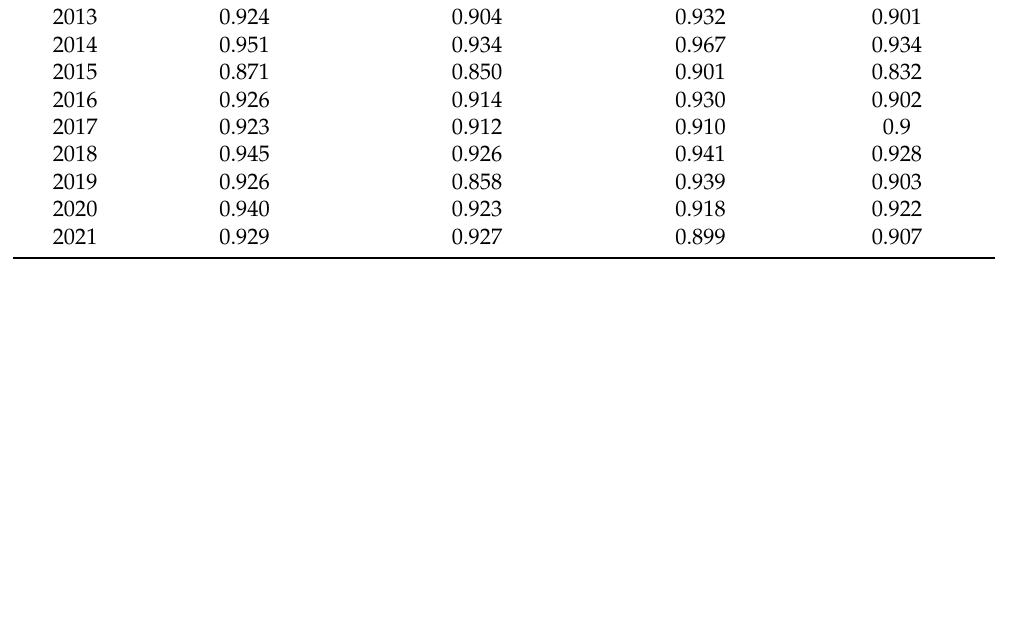
Table A3. Summary of accuracy values associated with the remote sensing interpretation of the marine cover in the study